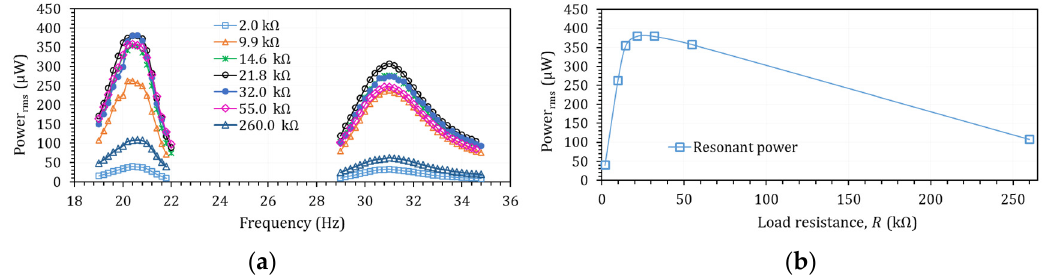
Figure 4. ( a ) Power versus frequency with different load resistances and ( b ) resonant output power for different loads.